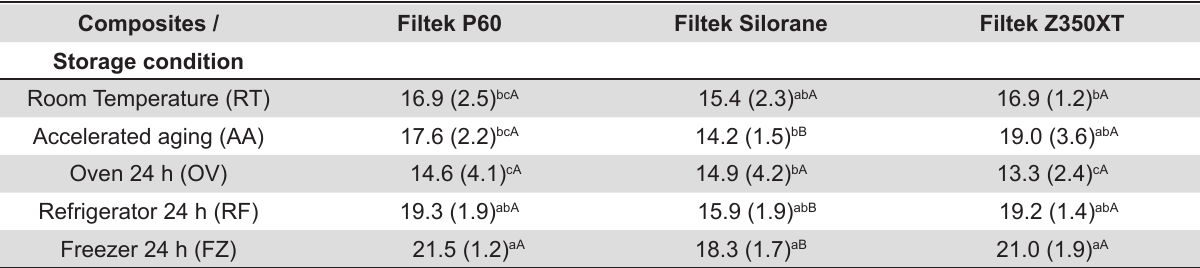
Mean values followed by different capital letters in row and small letters in column: significant (p<0.05) ( ): standard deviation Table 2- Mean of flexural modulus (E) regarding interaction Composite x Syringe storage condition